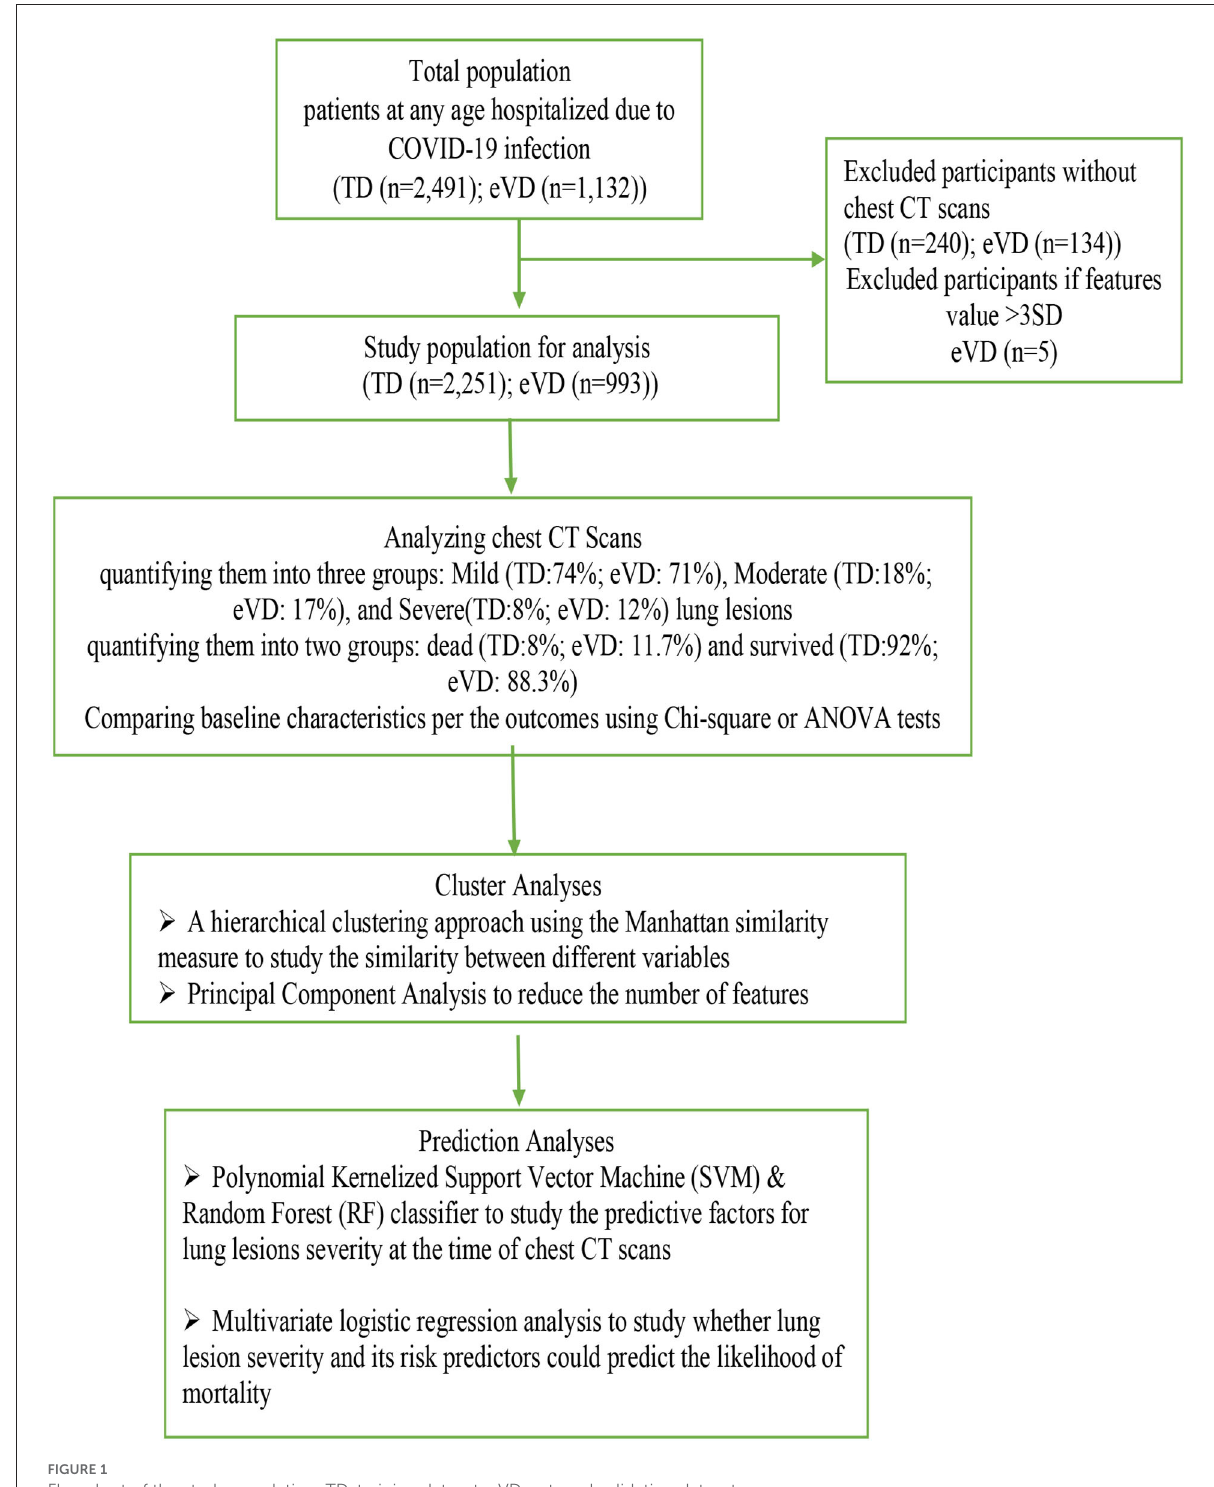
FIGURE1 Flowchart of the study population. TD, training dataset; eVD, external validation